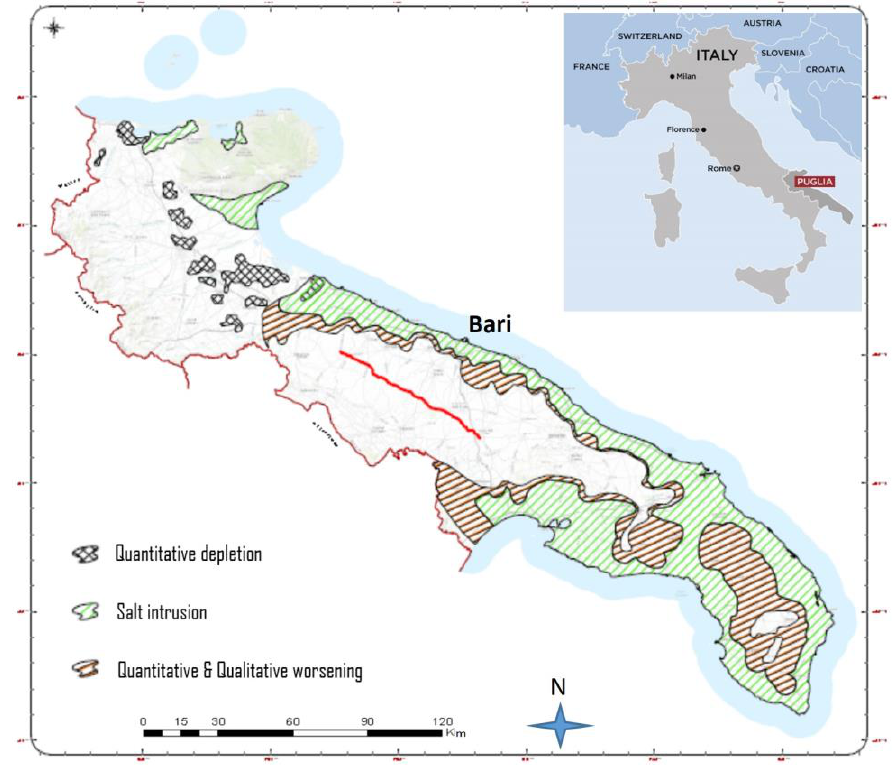
Figure 2. Groundwater vulnerable zone in Puglia [31].